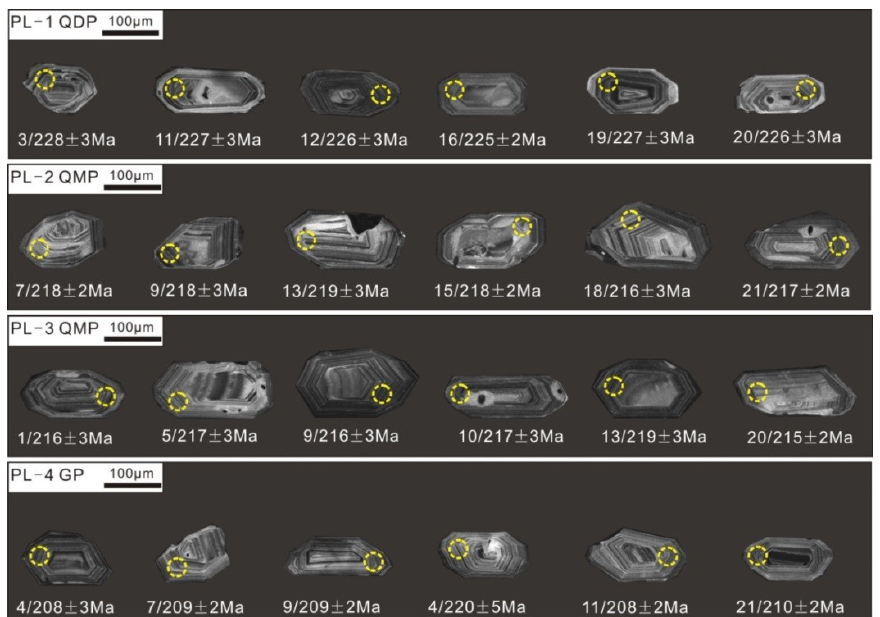
Figure 5. Cathodoluminescence (CL) images of respective zircon grains from the samples of Pulang porphyry intrusions. Yellow circles denote the locations of U–Pb dating. Abbreviations: QDP: Quartz